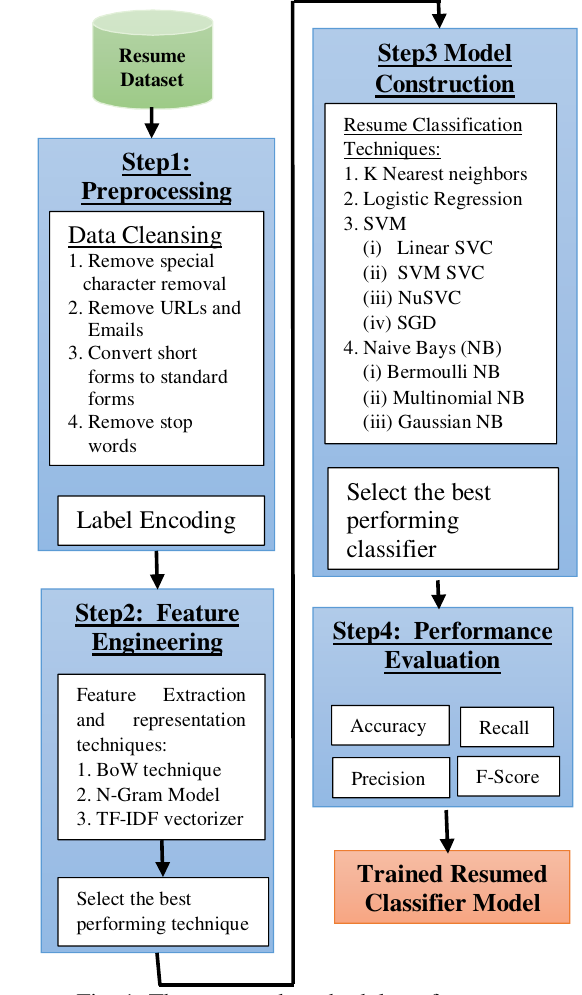
Fig. 1: The proposed methodology for resume